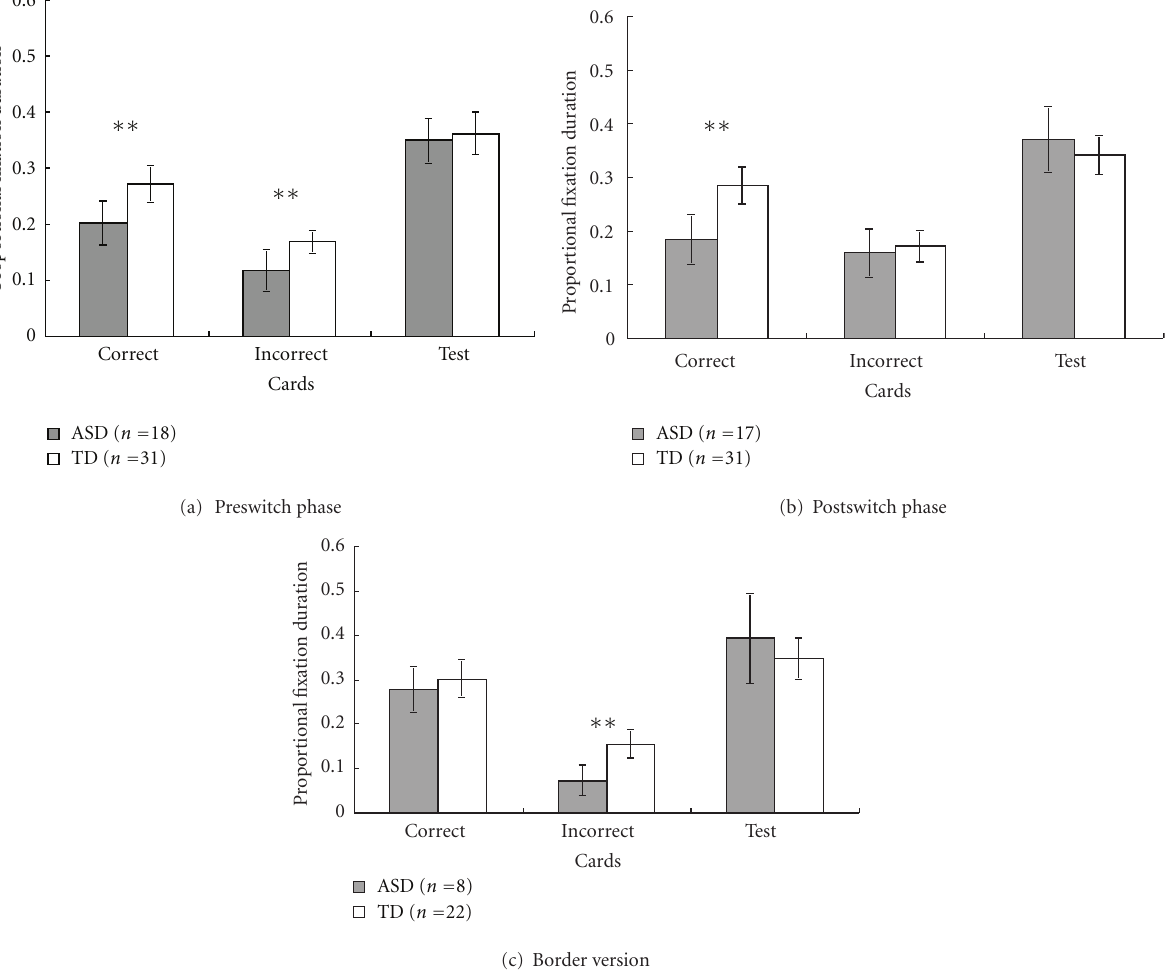
Figure 2: Proportional fixation durations within the correct, incorrect, and the test cards for ASD and TD children during the preswitch phase (a), the postswitch phase (b), and the border version (c). (Error bars represent 95% confidence intervals). ∗∗ P < .